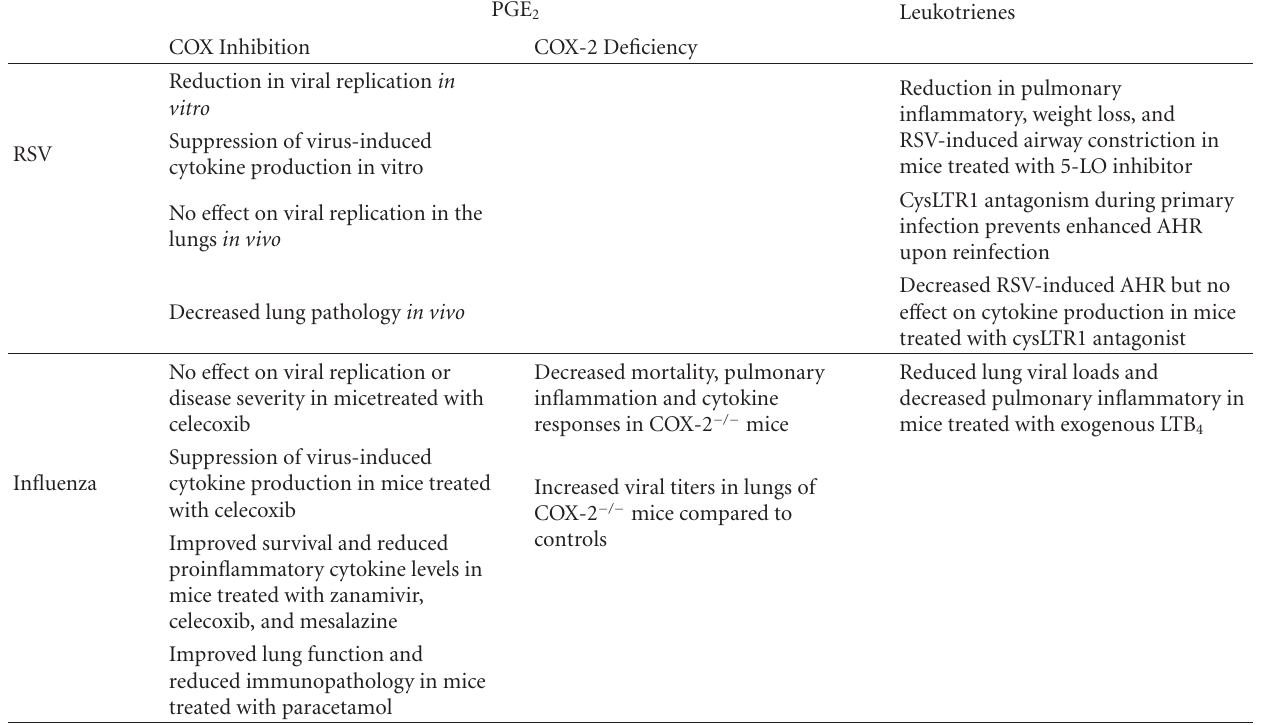
Table 2: E ff ects of PGE 2 and Leukotrienes on respiratory syncytial virus and influenza